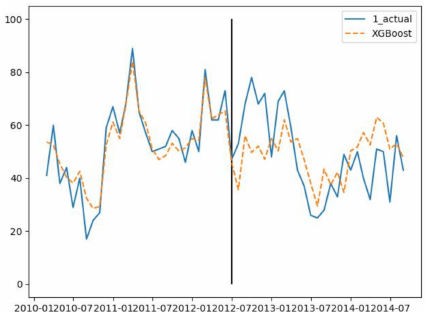
Figure 5. GBDT’s fitting and prediction results for group 1.